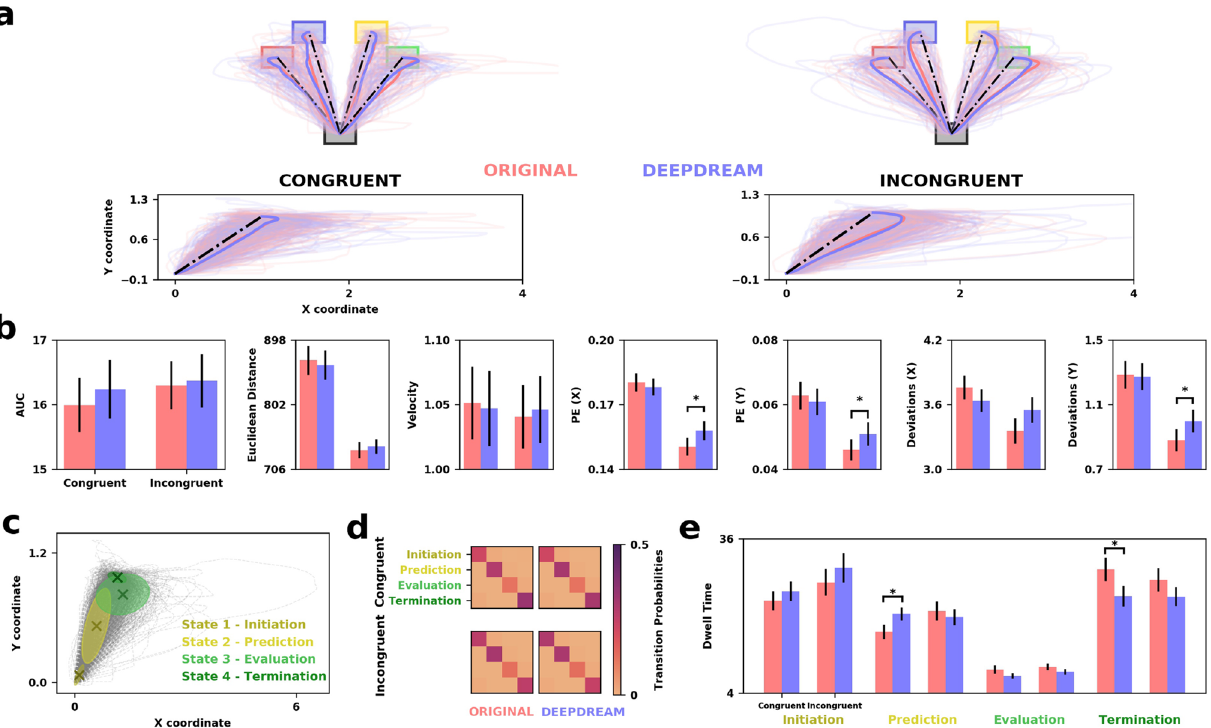
Figure 5. ( a ) On the top, mouse trajectories of OR (red) and DD (blue) spatially aligned to the four targets and divided by congruent (left) and incongruent (right) trials. On the bottom, mouse trajectories spatially aligned to the same initial (0,0) and ending (1,1) point. ( b ) Barplots depicting the measures applied to the mouse trajectories. Error bars indicating SEM and horizontal bars representing statistical significance. ( c ) GMM clusters of mouse trajectories. Grey dashed lines represent the trajectories, crosses are the centroids of each cluster while ellipsoids are the covariances. ( d ) Transition probability matrices for each condition and split between congruent and incongruent trials. ( e ) Barplots representing dwell time for each state. Error bars indicating SEM and horizontal bars representing statistical